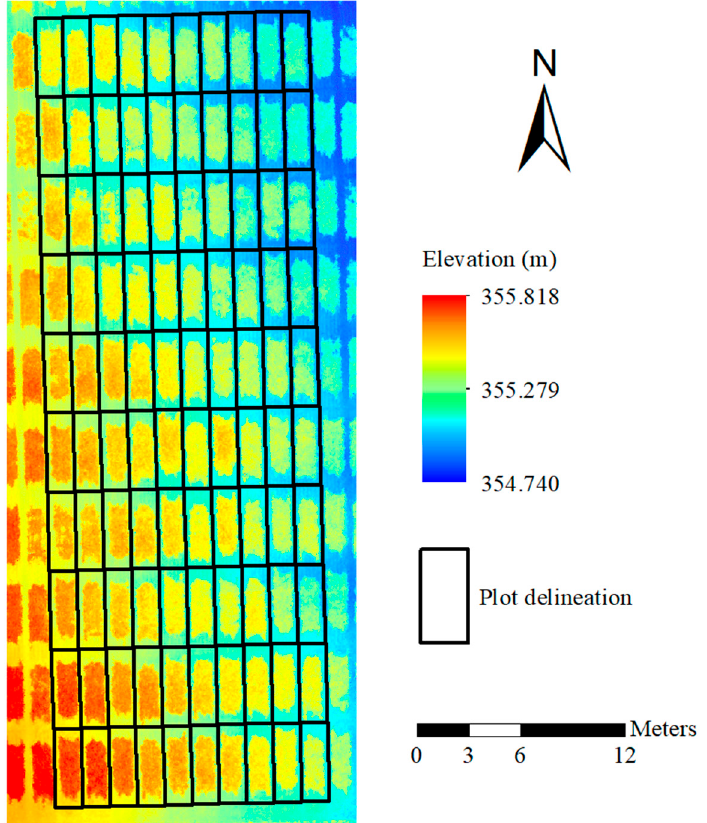
Figure 7. Digital surface model (DSM) map of the investigated 100 plots with plot delineation.